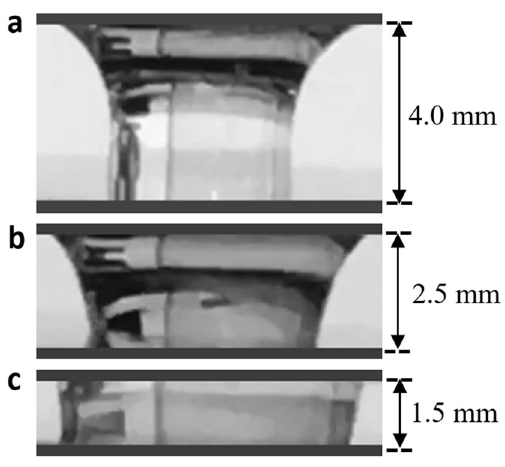
Figure 4. Video freeze shots of three stages of electrolyte between electrodes during modulation: ( a ) 4 mm apart, ( b ) ~ 2.5 mm apart, and ( c ) 1.5 mm apart. Electrolyte geometry suggests that the liquid completely forms a cylindrical disk while electrodes are at the minimum distance apart (maximum electrode–electrolyte interfacial area).